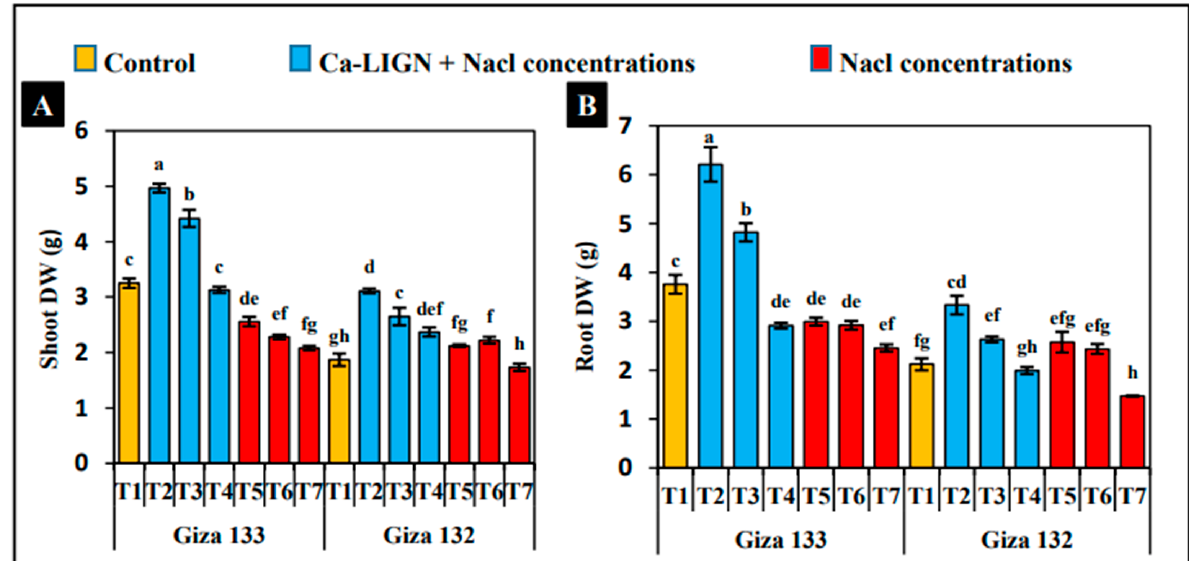
Figure 1. Effect of different treatments: (T1) control, (T2) 100 mM NaCl + Ca-LIGNO, (T3) 200 mM NaCl + Ca-LIGNO, (T4) 300 mM NaCl + Ca-LIGNO, (T5) 100 mM NaCl, (T6) 200 mM NaCl, and (T7) 300 mM NaCl on the average ( A ) shoot dry weight (DW)and ( B ) root dry weight (DW) of the two barley cultivars, Giza133 and Giza132, during two seasons, 2019/2020 and 2020/2021. Data represent the mean ± SE (n = 4). The same letter indicates no significant difference ( p ≤ 0.05).